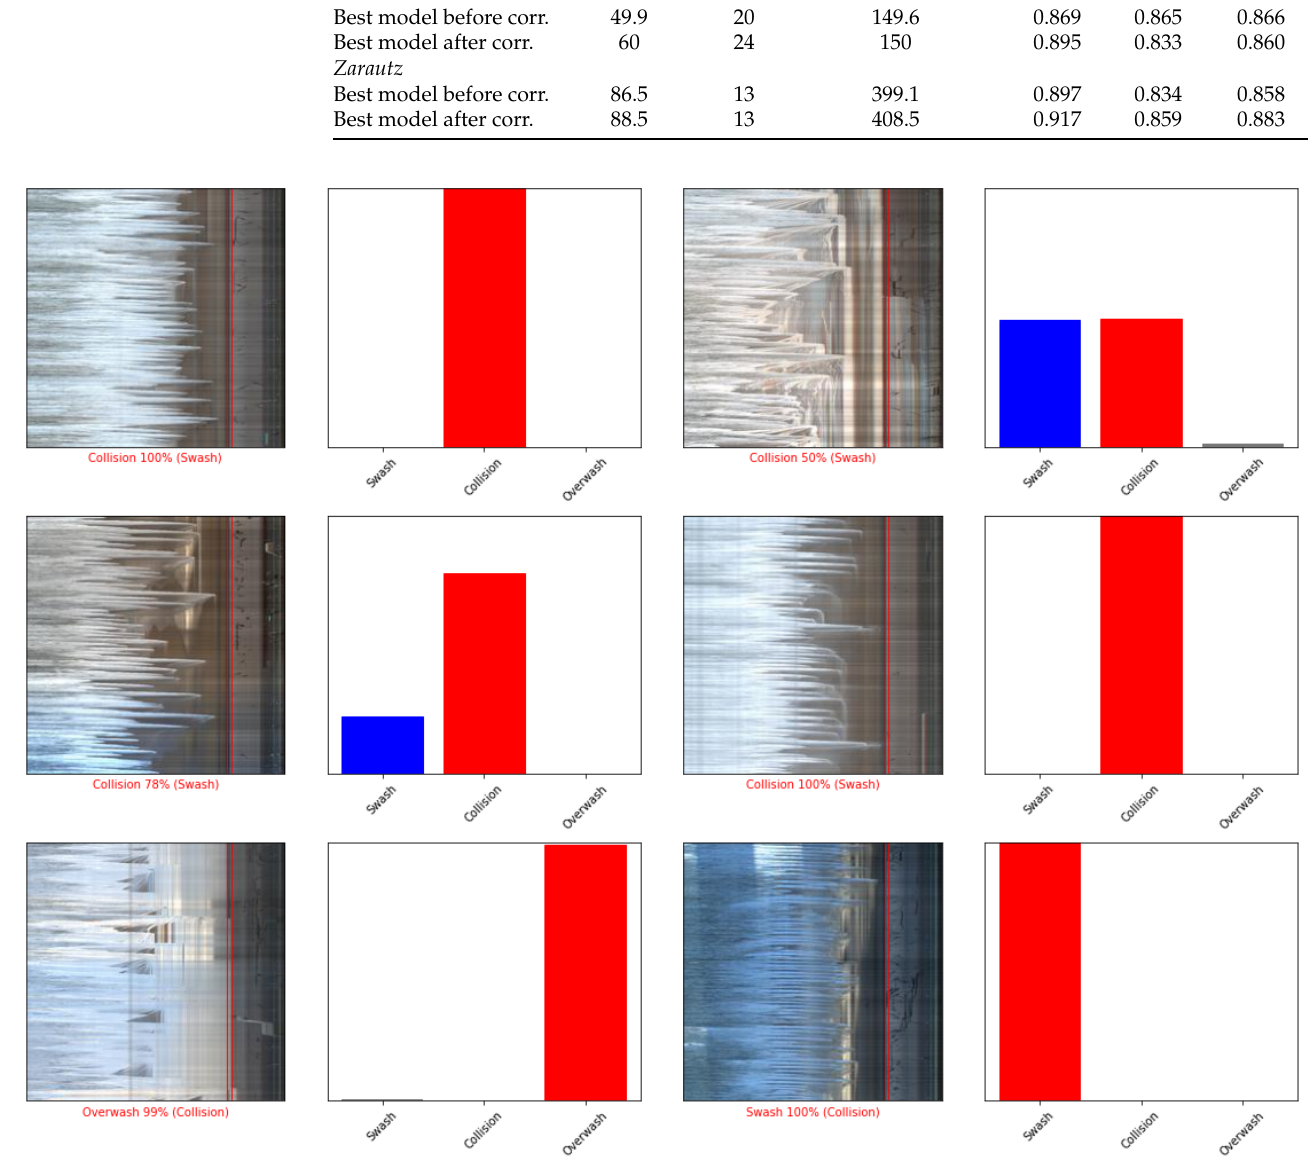
Figure 6. Prediction errors on the test set of Biarritz by the best CNN. The storm impact regime predicted is written under each timestack, and the ground truth is written in parentheses. The probabilities of belonging predicted by the CNN are represented on the right side of each timestack (red = prediction made by CNN, blue = ground truth). The red line in the timestack represents the position of the